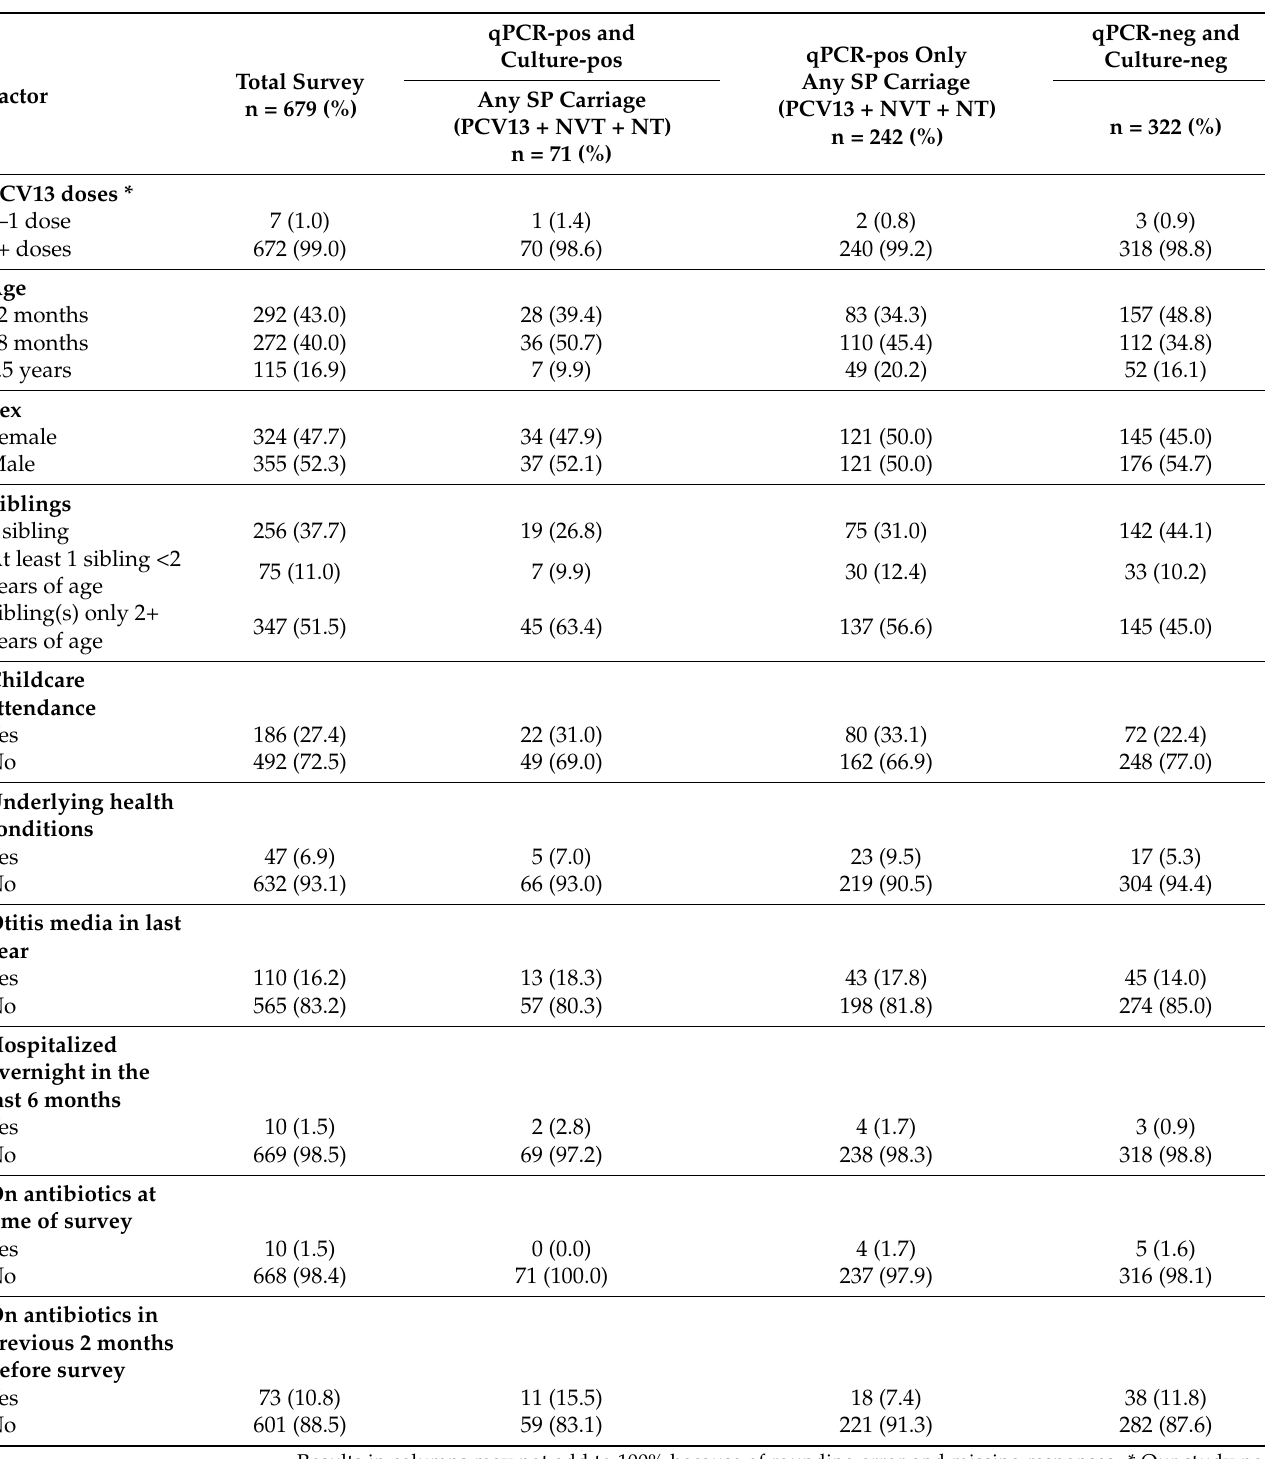
Table 1. Demographic and Clinical Factors of Study Participants From the 2016